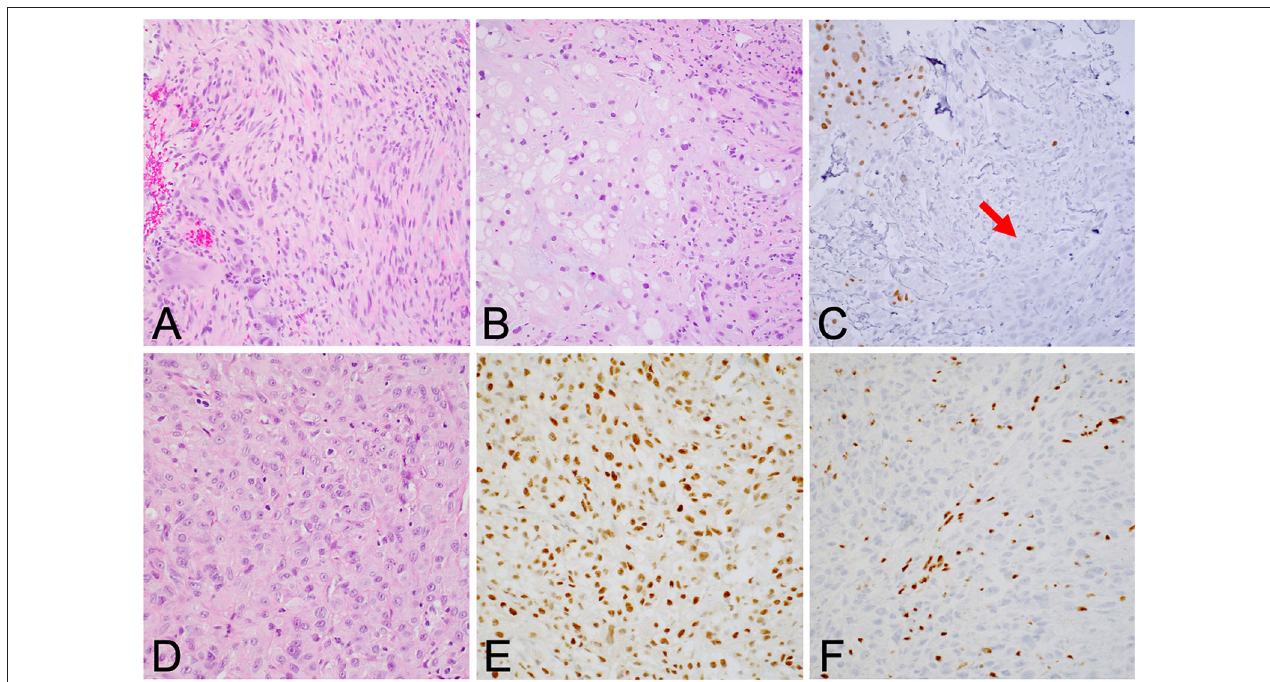
FIGURE 3 | (A) Dedifferentiated chordoma contains regions of high-grade sarcoma, frequently juxtaposed with regions of conventional chordoma (B) . (C) Brachyury positivity is often negative in the dedifferentiated component (arrow). (D) Poorly differentiated chordoma exhibits higher cellularity than conventional chordoma and occasionally shows rhabdoid morphology. (E) Brachyury is reliably positive, and (F) SMARCB1 (INI-1) loss in tumor cells is characteristic of this entity.